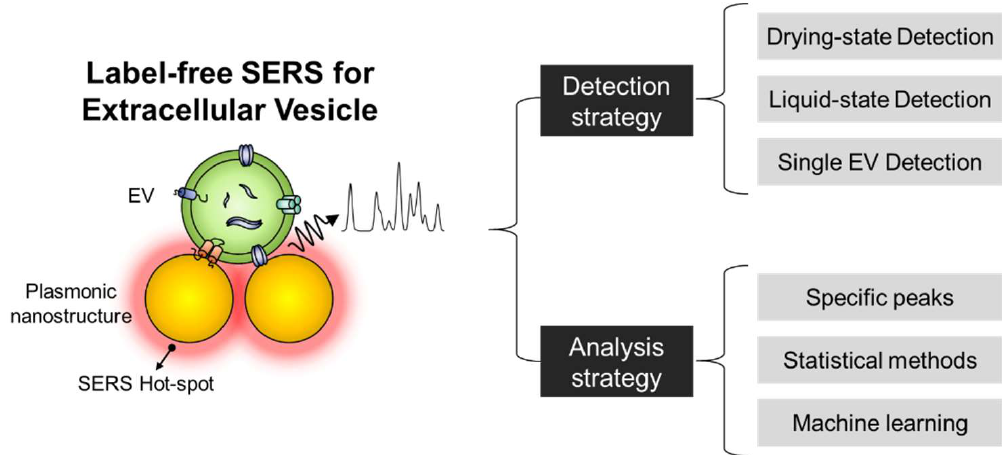
Figure 1. Label-free surface-enhanced Raman spectroscopy (SERS) of extracellular vesicles (EVs). The label-free SERS approach can be categorized into two major strategies of signal detection and analysis.